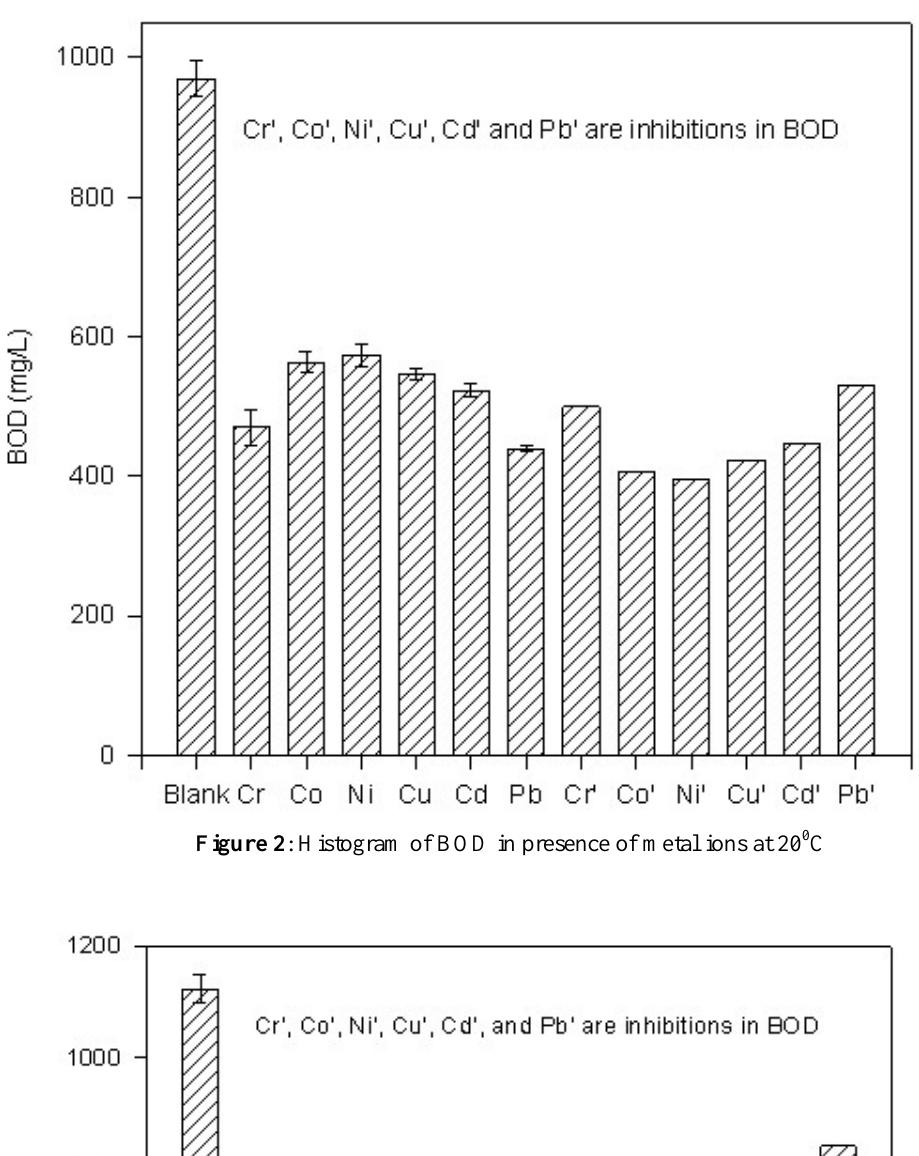
Figure 2 : Histogram of BOD in presence of metal ions at 20 0 C